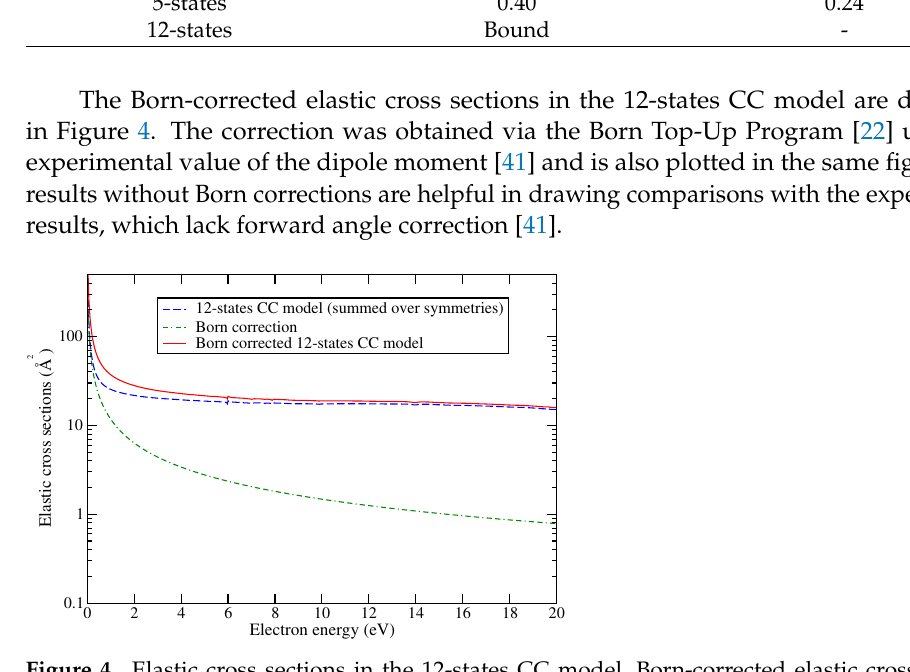
Figure 4. Elastic cross sections in the 12-states CC model. Born-corrected elastic cross sections, line curve; Born correction, dashed dotted curve; elastic cross sections without Born correction, dashed